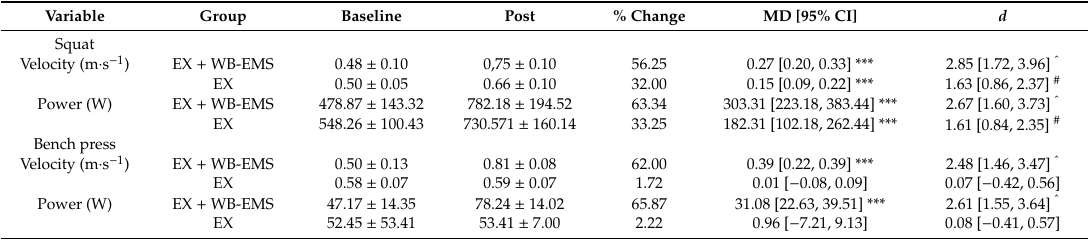
Table 3. Summary of baseline and postintervention data of the mechanical variables of strength exercises for each group EX + WB-EMS ( n = 16) and EX ( n = 16).